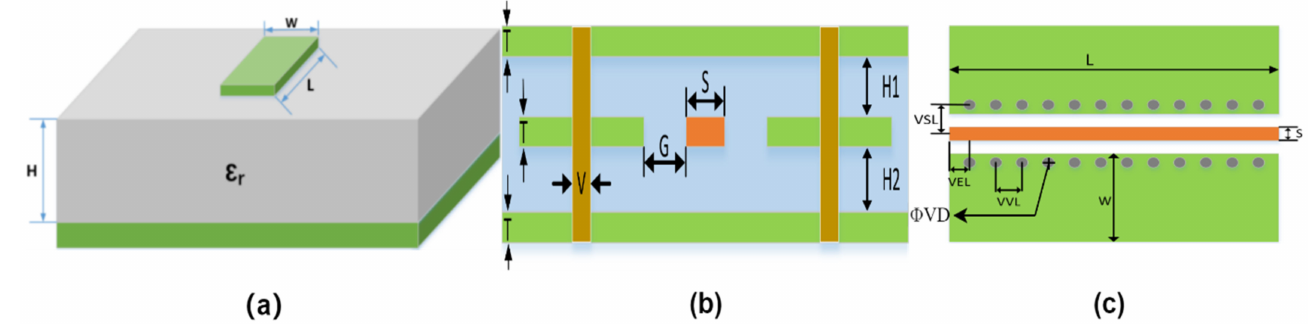
Figure 5. ( a ) Structure of multilayer coplanar waveguide with upper and lower metal plates; ( b ) sectional view of single- ended coplanar waveguide transmission line; ( c ) top view of single-ended coplanar waveguide transmission